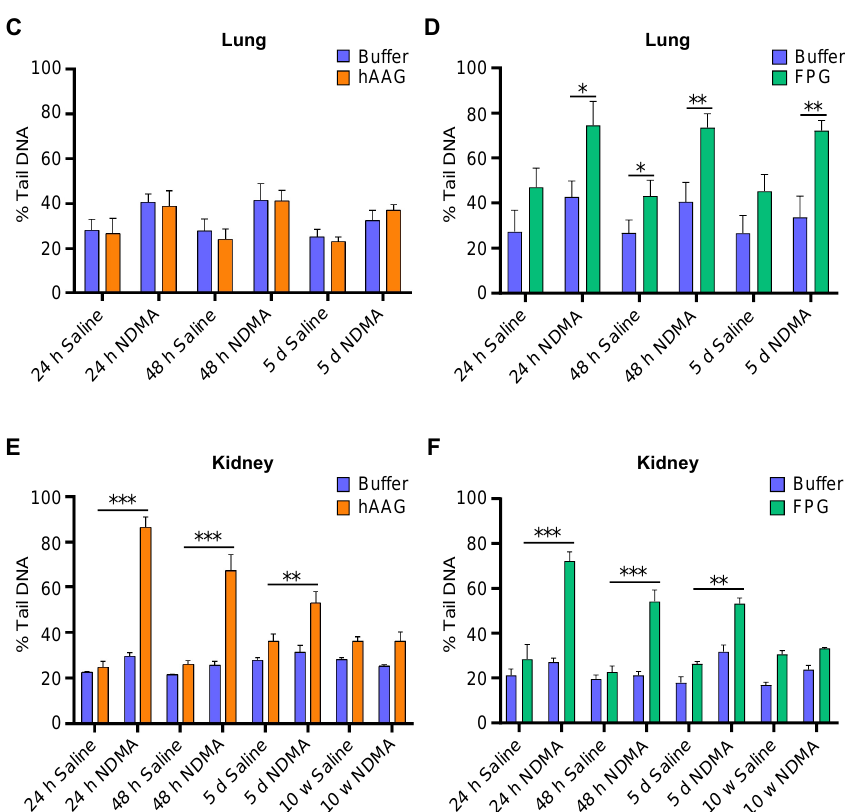
Figure 6. NDMA-induced base lesions can be detected by the CometChip. Mice were exposed to either saline or 10 mg/kg of NDMA, and liver, lungs and kidneys were collected 24 h, 48 h, 5 days and 10 weeks after injection. Cell suspensions from the tissues were analyzed with enzyme-modified alkaline CometChip. Results show DNA damage following assay modification with ( A , C , E ) hAAG enzyme or hAAG buffer and ( B , D , F ) Fpg enzyme or Fpg buffer. Percent tail DNA represented as mean of three mice ± SD. Unpaired Student’s t -test, * p < 0.01, ** p < 0.01, *** p < 0.001. When Fpg enzyme was incorporated, there was a significant increase in percent tail DNA in both the liver and lung tissues that were exposed to NDMA compared to samples that were incubated in Fpg buffer only (Figure 6B,D). However, Fpg also led to an increase in percent tail DNA in tissues from saline-treated animals, which is consistent with normal levels of oxidative stress causing an increase in oxidized purines. In the kidneys, we ob- served a significant increase in percent tail DNA following the addition of hAAG and Fpg enzymes that decreased overtime, suggesting the presence of NDMA-induced base dam- age (Figure 6E,F). These results suggest that the removal of base lesions is slower in the